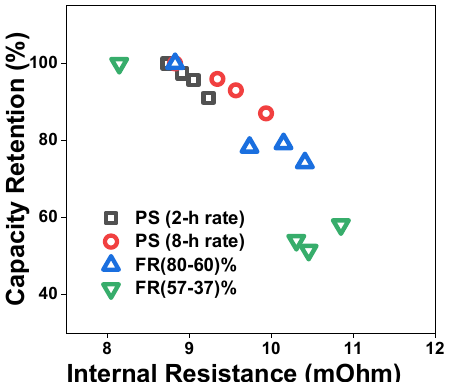
Figure 6. Capacity retention vs. internal resistance profile for four duty cycles.